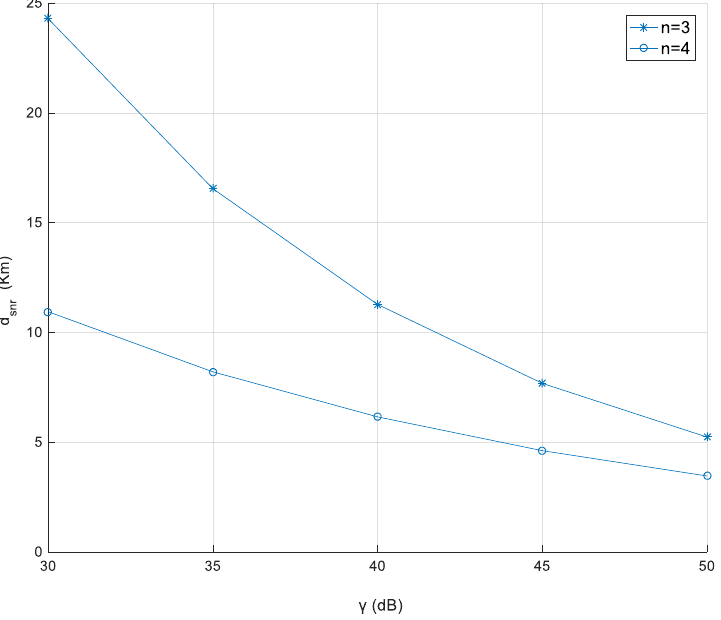
Figure 9. The relationship of distance threshold ( 𝑑 𝑠𝑛𝑟 ) according to different SNR thresholds ( γ ).